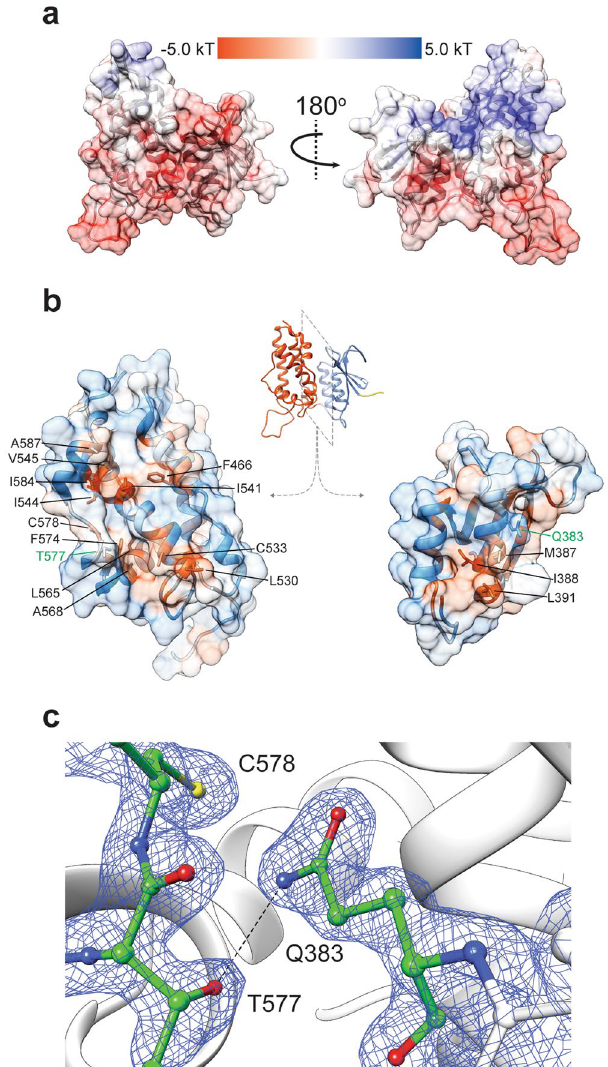
Figure 2. Surface and inter-domain interface analyses. ( a ) mCLIC6 electrostatic surface potential. ( b ) Inter-domain interface hydrophobicity analysis. Hydrophobic patches are shown in red. Positions participating in interface formation are indicated. ( c ) Detailed illustration of the Q383-T577 hydrogen bond (dashed black line), overlaid with 2 F o – F c map contoured at 1 σ (blue mesh). Indicated residues are shown as sticks and colored by